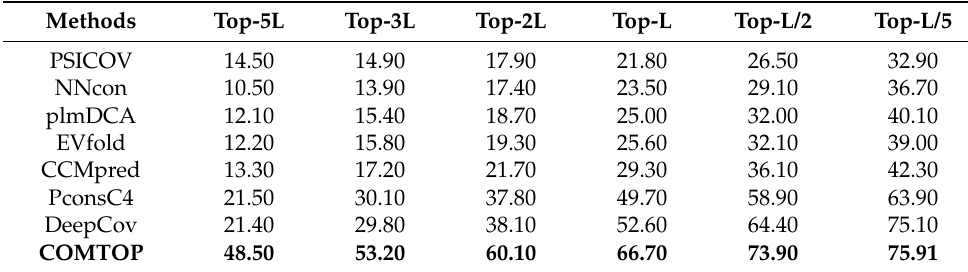
Table 3. The prediction accuracy on CASP13 target domains for COMTOP with seven